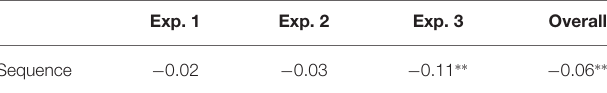
TABLE 1 | Pearson’s r for correlations between playback sequence and acoustic comfort.